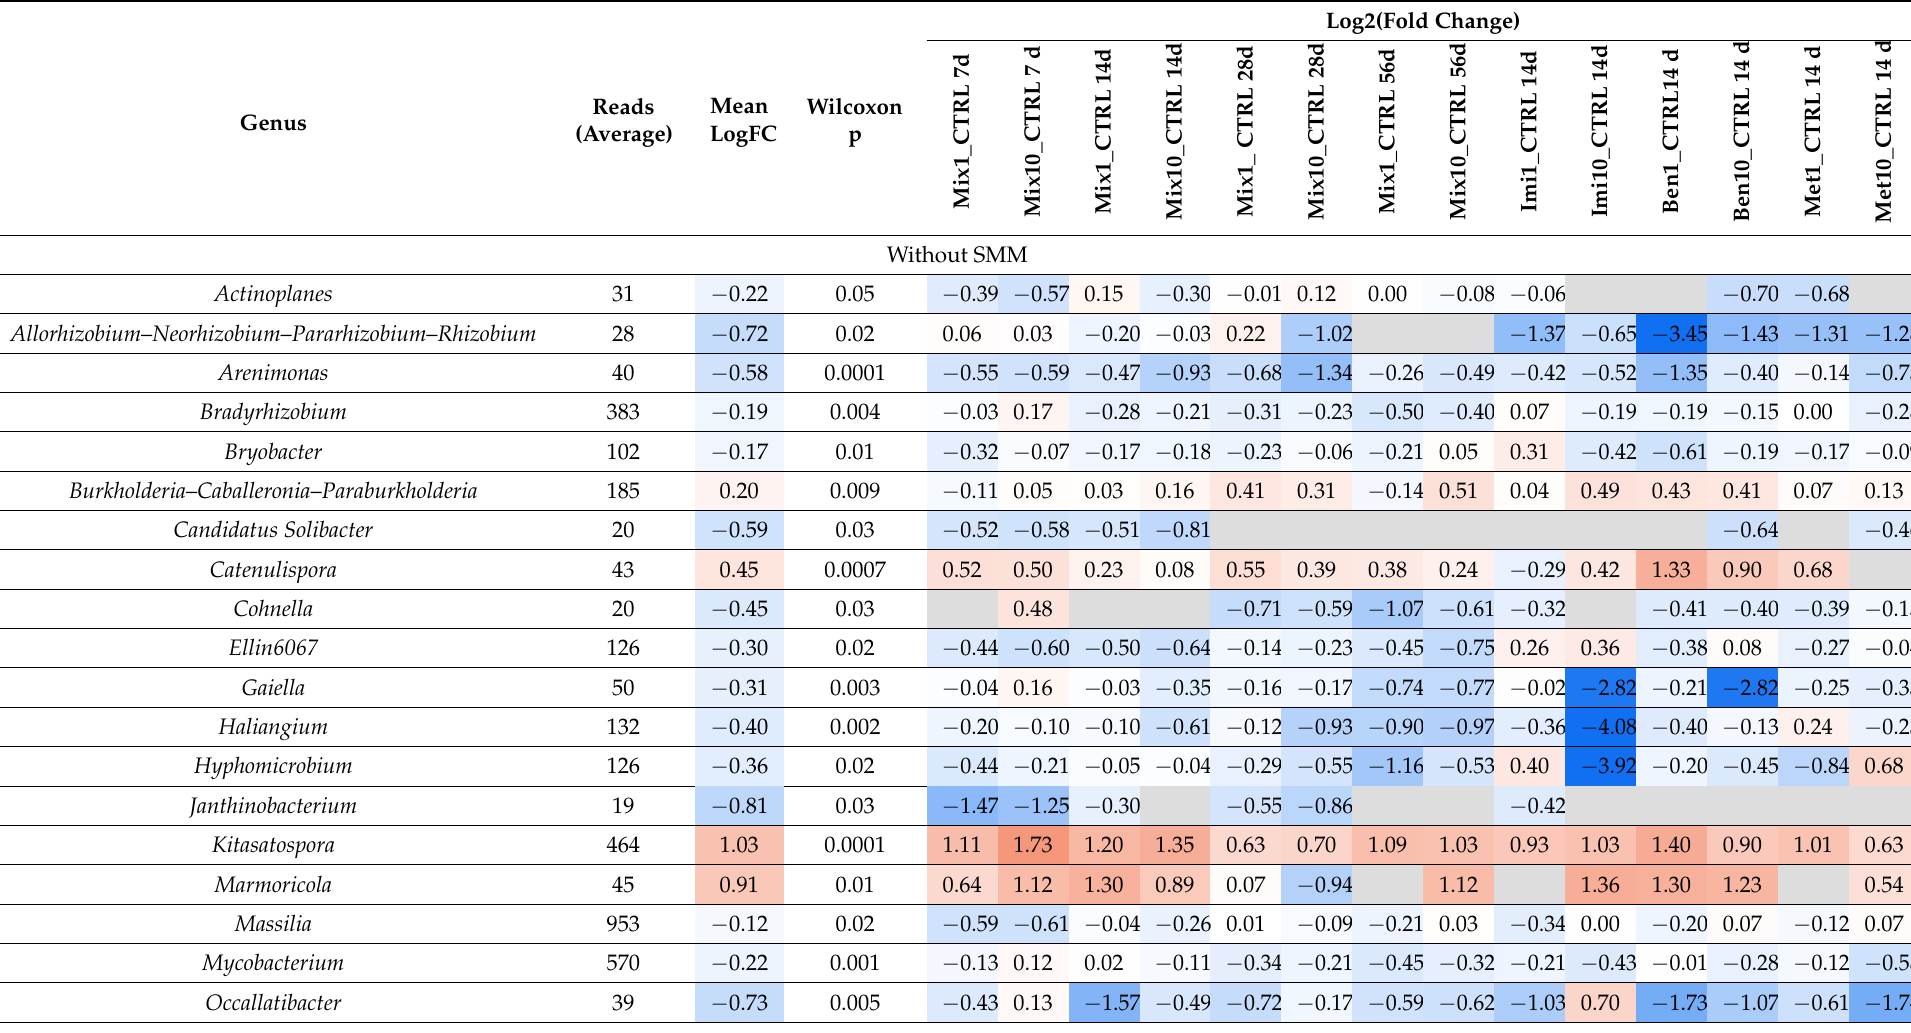
Table 8. Pairwise comparison of abundances of various bacterial genera between control and treated soil sample.